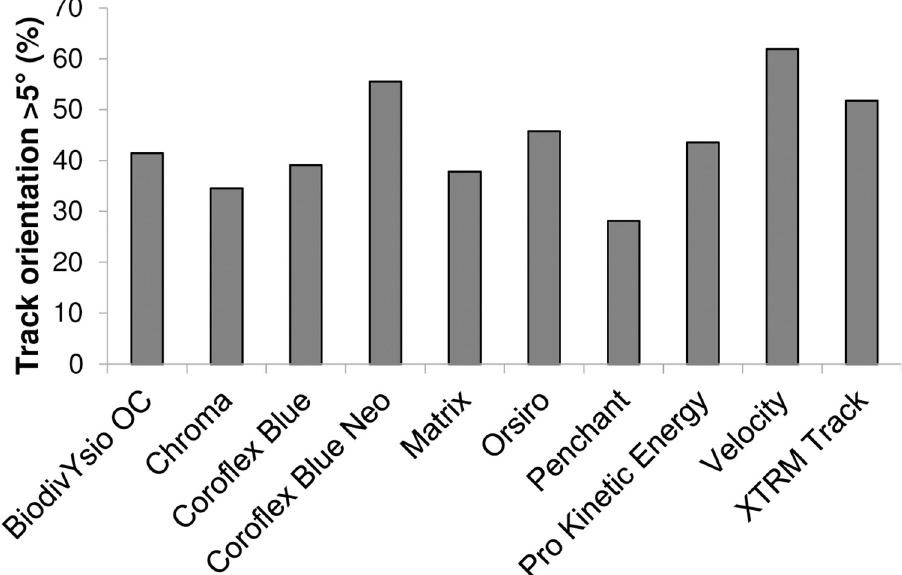
Fig 4. Particle track orientation in coronary stents. The orientationof tracked particle streamlines moving through coronary stents deployed within model vessels was measured to determine whether the workflow can assess the impact of stent design on the direction of flow. The length of tracks at an angle greater than ± 5˚ of the direction of flow (0˚) is shown as a percentage of the total length of tracks within each stent. This threshold was applied to ensure that stent- induced flow deviation was captured while minor deviations, due to equipment disturbance or manual tracking errors, were omitted.